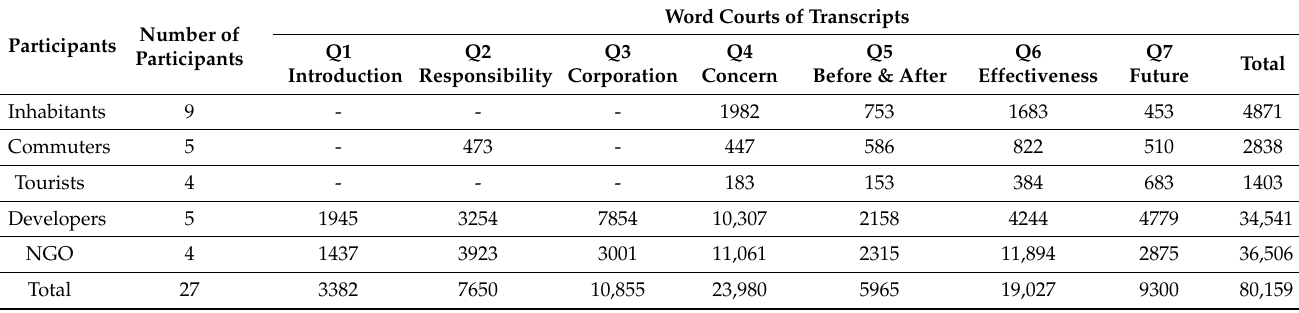
Table 1. Participants and quantity of the interview data.